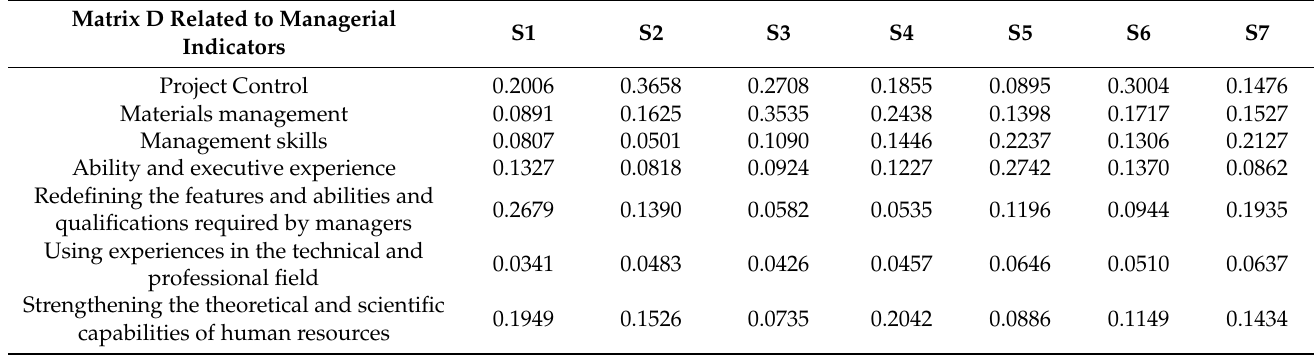
Table 6. Normalized matrix related to management indicators.